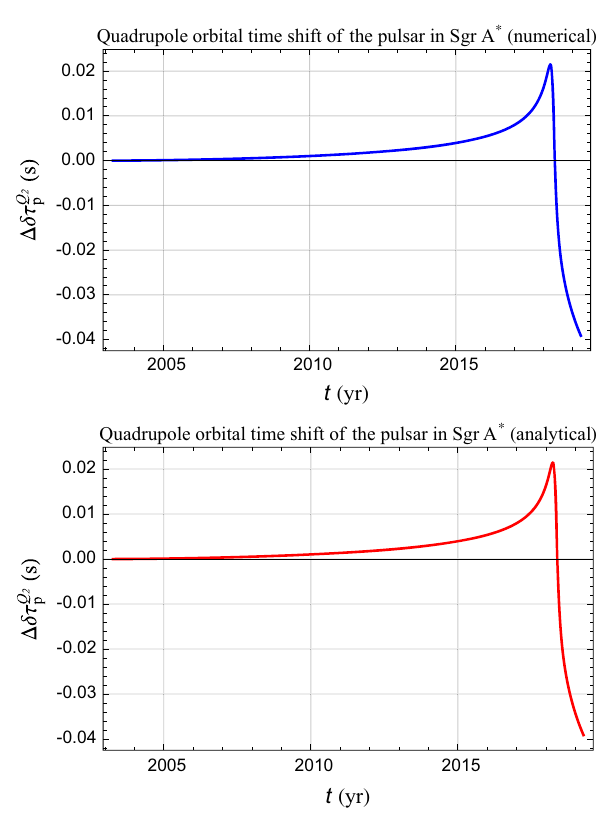
Fig. 3 Upper row , blue curve (cid:2)δτ Q 2 p ( t ) , in s, of a hypothetical pul- sar in Sgr A ∗ as the outcome of the difference between two numerical integrations of the equations of motion in Cartesian coordinates over a time span ranging from, say, t 0 = 2003 . 271 to t 0 + P b . Both the inte- grations have the same (Keplerian) initial conditions for f 0 = 139 . 72 ◦ , corresponding to t 0 = 2003 . 271, and differ by the quadrupole-induced acceleration, which was purposely switched off in one of the two runs. Lower row , red curve (cid:2)δτ Q 2 p ( t ) , in s, of a hypothetical pulsar in Sgr A ∗ obtained analytically from Eqs. (26) to (27) and the instantaneous changes of the Keplerian orbital elements, not displayed in the text, induced by Eq. (71). It turns out that the net shift after a full revolu- (cid:4) (cid:3) = − 0 . 0391 s. The (cid:2)δτ Q 2 tion starting at t 0 = 2003 . 271 amounts to p orbital configuration of the S2 star, quoted in Table 1, was adopted for the putative pulsar in Sgr A ∗ along with i • = 146 . 7 ◦ , ε • = 148 . 8 ◦ (51), on the other hand, it depends on the orbital semimajor axis through a − 1 . As far as (cid:2)δτ J 2 p ( f ) is concerned, it will not be displayed explicitly because it is far too